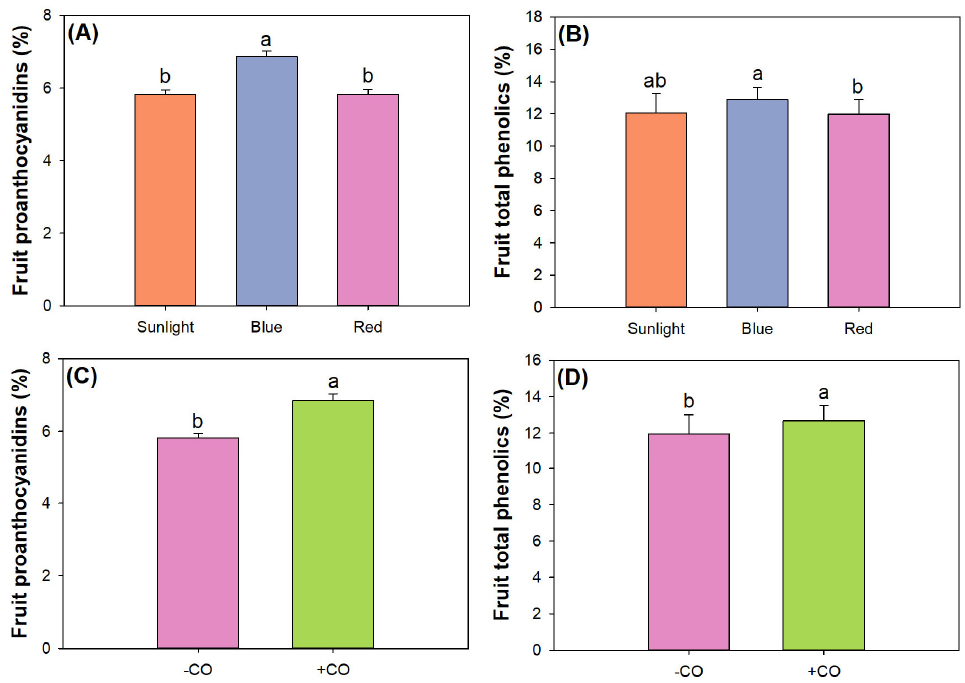
Figure 8. Quality assessment of fruits in black chokeberry ( Aronia melanocarpa (Michx.) Elliott 1821) exposed to separate light-type (sunlight, blue light-emitting diode (LED), red LED), chitosan oligosaccharide (CO), and spent mushroom residue (SMR) treatments: ( A ) light effect on leaf proanthocyanidins; ( B ) light effect on total phenolics in fruits; ( C ) CO effect on fruit proanthocyanidins; ( D ) CO effect on total phenolics in fruit. Different letters mark significant difference according to Tukey test at 0.05